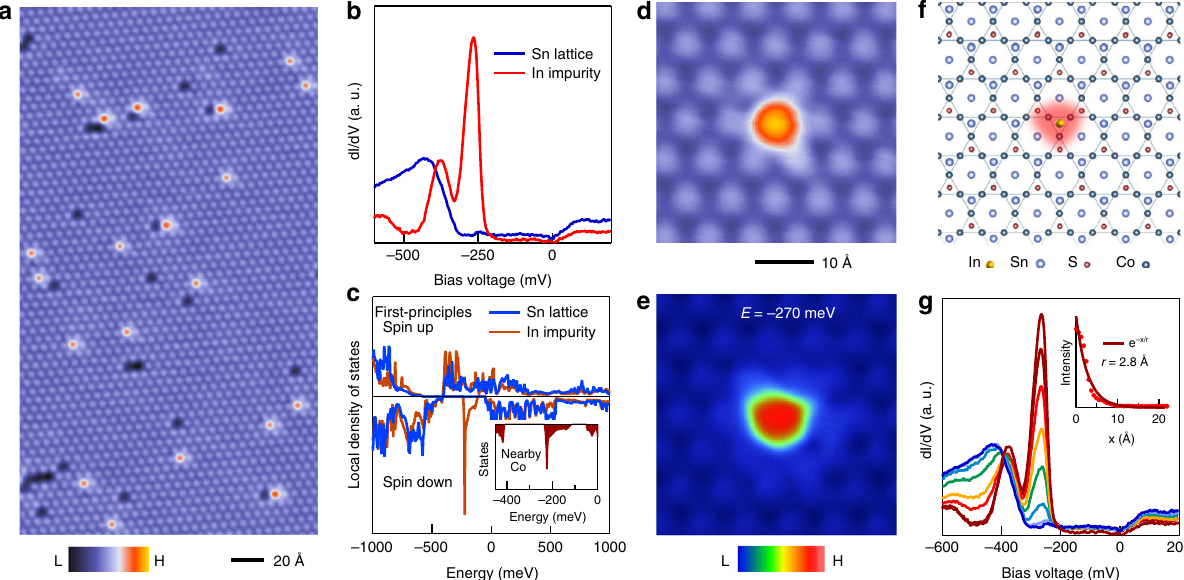
Fig. 1 Engineered atomic impurity state in a topological magnet. a Atomically-resolved topographic image of Sn layer of 1% In doped Co 3 Sn 2 S 2 . b Differential conductance spectrums taken on the Sn lattice (blue) and at the In impurity (red), respectively. c First-principles calculation 13 of the spin- resolved local density of states of the Sn lattice (blue) and an In impurity (red), which shows a magnetic impurity resonance. The inset shows the spin- down states of the Co atom closest to the In impurity. d Topographic image of an isolated impurity. e Corresponding differential conductance map taken at E = − 270meV (resonance energy). f Correlation between the atomic structure and the pattern in the differential conductance map. g Differential conductance spectra taken across the surface with spatial variation from the center of the In impurity (dark red) to far away (blue). The inset shows the exponential fi t to the spatial decay of the impurity